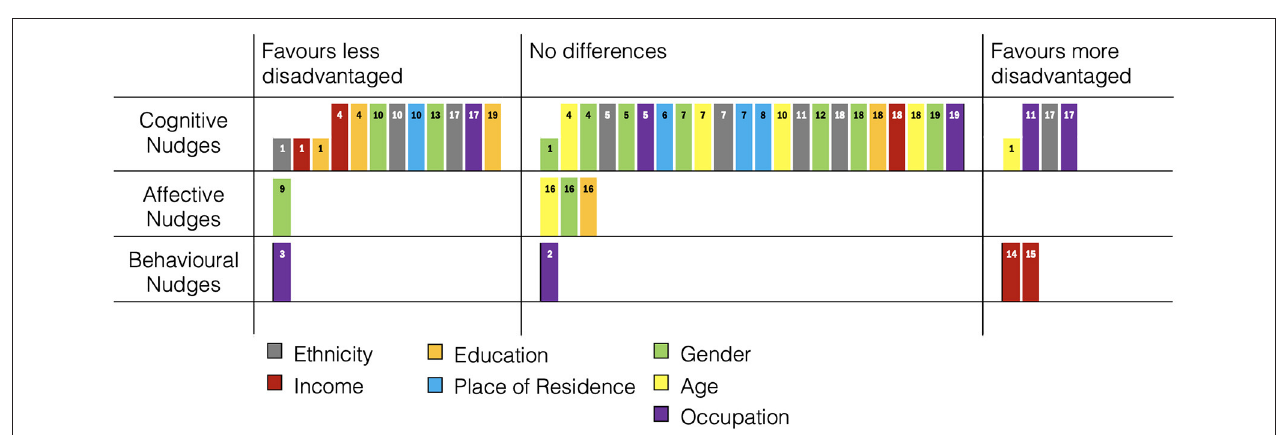
FIGURE 1 | PRISMA flow diagram.